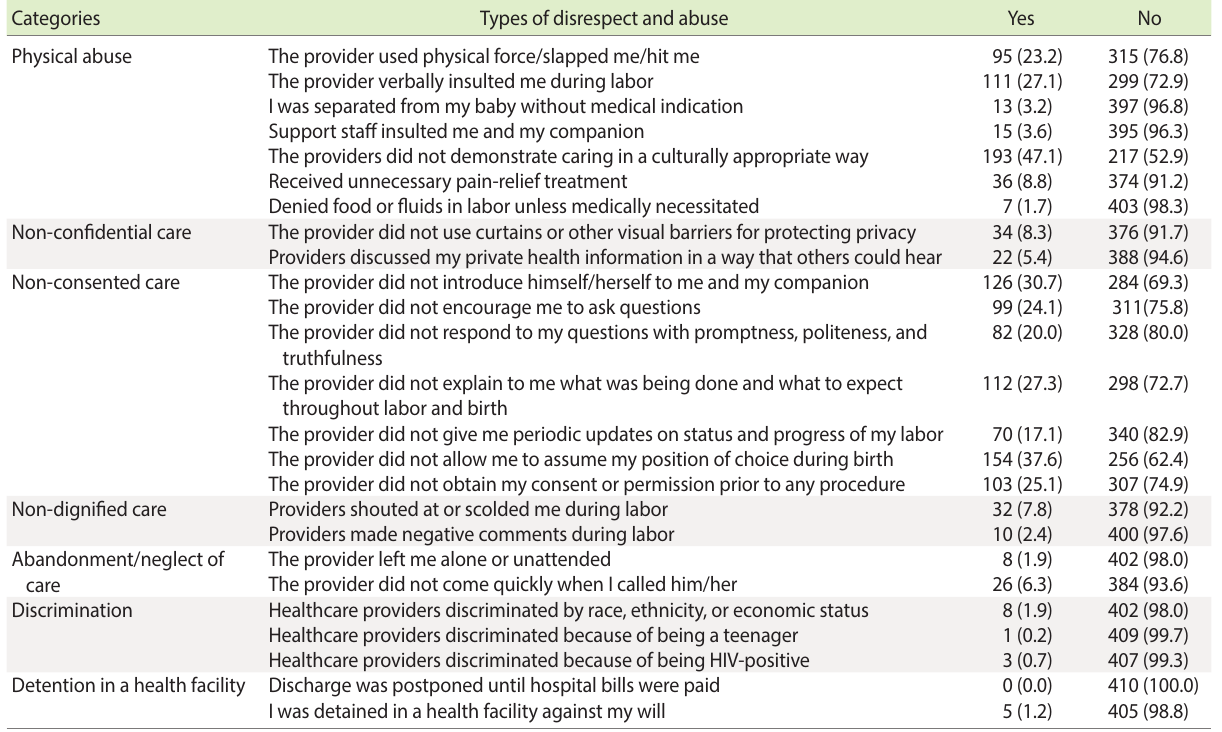
Table 3. Category and type of disrespect and abuse reported by mothers during childbirth, Bahir Dar, 2017